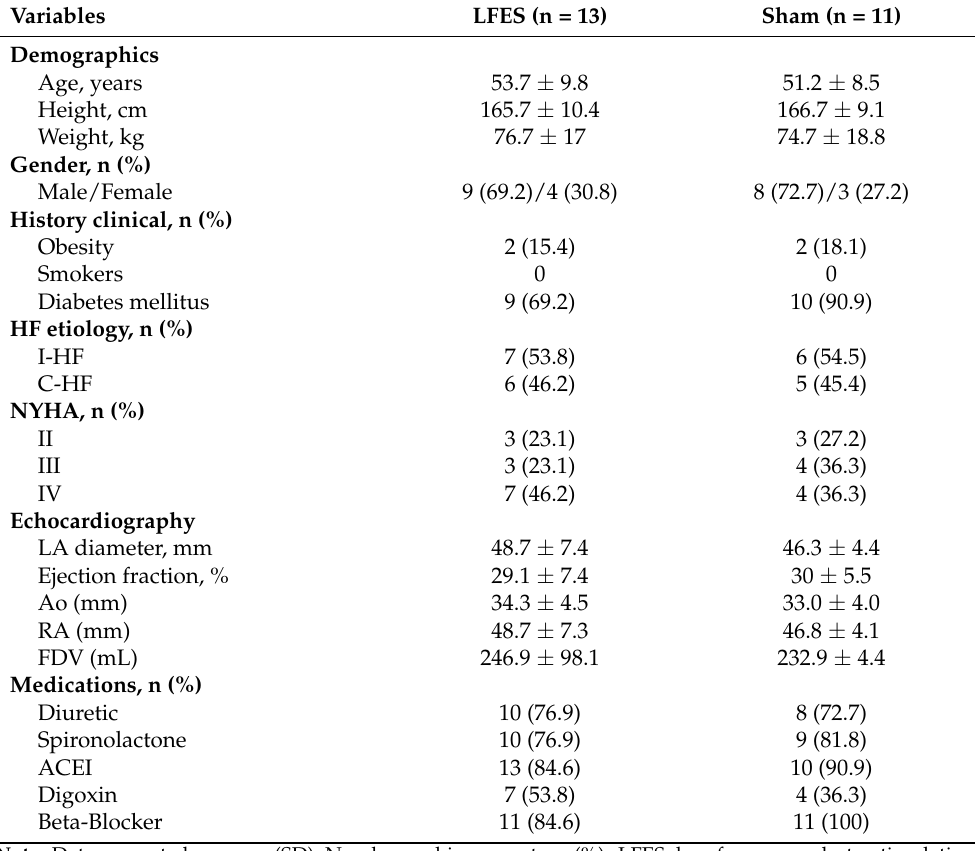
Table 1. Demographic characteristics and clinical history of HF